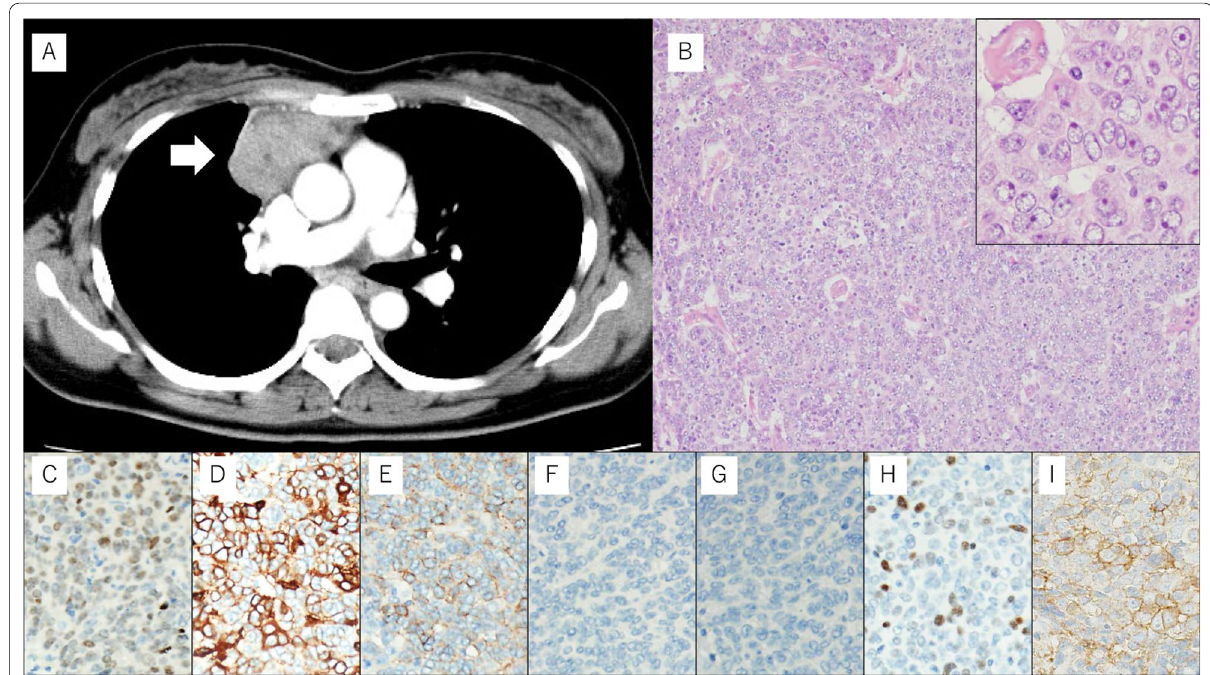
Fig. 1 A Chest computed tomography imaging of the primary tumor (arrow). B Pathological examination of the primary tumor reveals thymic squamous cell carcinoma. Hematoxylin and eosin staining; original magnification the primary tumor is positive for PAX8 ( C ), CD5 ( D ), and c-KIT ( E ), while intratumoral lymphocytes are negative for TdT ( F ) and CD1a ( G ). The primary tumor demonstrates low expression of p53 ( H ) and positive staining for programmed death-ligand 1 ( I ). Original magnification